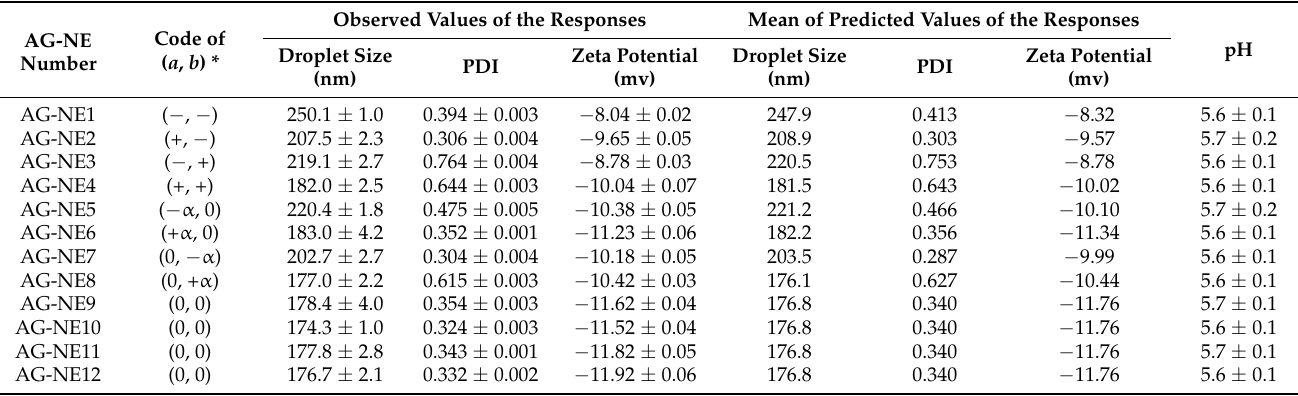
* The letter a, and b represented pressure and number of homogenization cycles, respectively. The symbols as listed; ( − ), (0), (+), ( − α ), and (+ α ) were coded values of factors at various levels, i.e., a low level, a center point, a high level, a low level of axial point, and a high level of axial point,